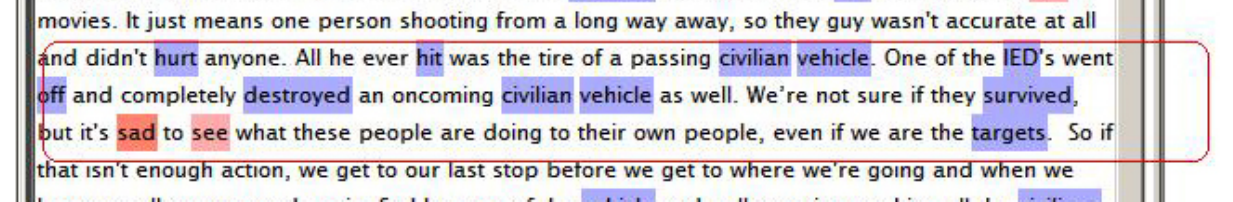
Figure 2. A section of an annotated blog describing the trauma of war